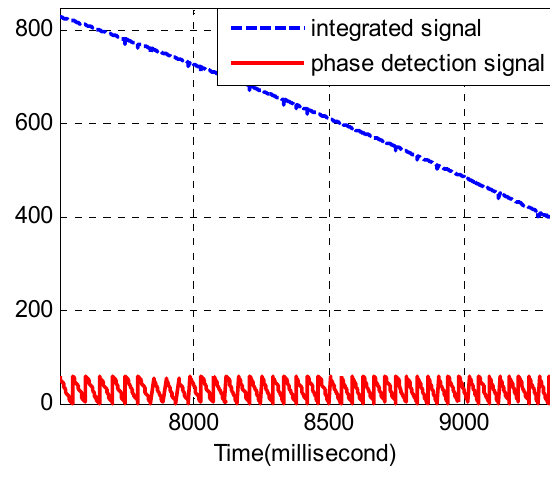
Figure 10. The phase detection and integrated signal in the backward